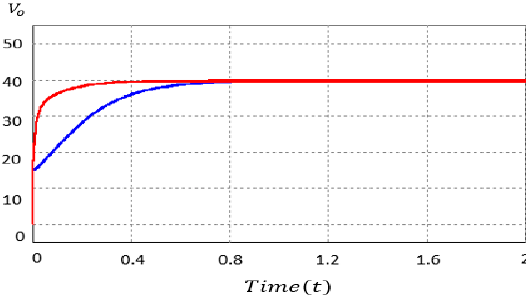
Figure 17. Response time for different controllers.